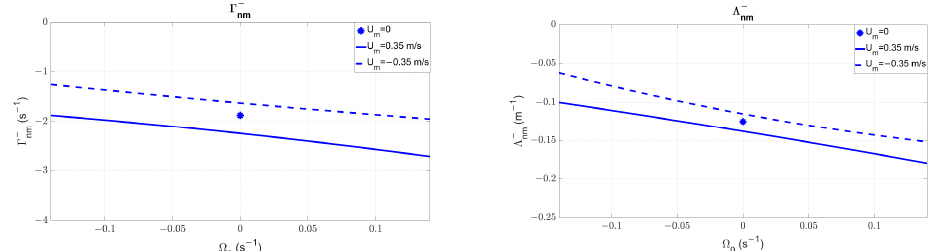
Figure 15. 𝛤 (stream function coefficient) and 𝛬 (surface elevation coefficient) of the nm-negative